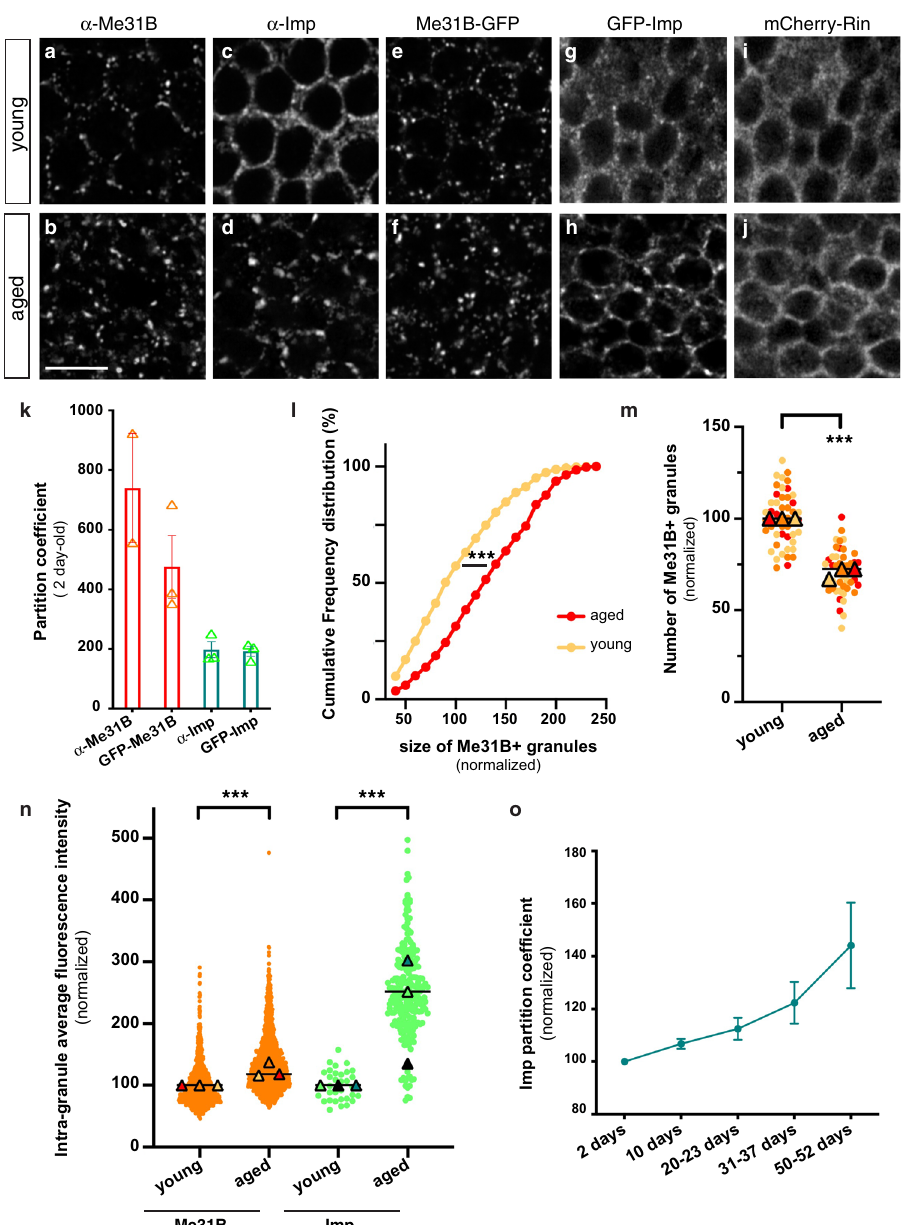
Fig. 1 Me31B and Imp condensate into larger cytoplasmic granules in aged brains. a – j Cell bodies of MB γ neurons imaged from 1 – 2 day- ( a , c , e , g , i ; young), or 37 – 38 day- ( b , d , f , h , j ; aged) old brains. Brains were stained with anti-Me31B ( a , b ) or anti-Imp ( c , d ) antibodies. Me31B-GFP ( e , f ), GFP-Imp ( g , h ) and mCherry-Rin ( i , j ) were expressed from their endogenous locus. Note that dark nuclei occupy most of the soma, and that the cytoplasmic signal is restricted to the cell periphery. Scale bar: 5 μ m. k Mean granular:cytoplasmic intensity ratio (partition coef fi cient) in brains of 1 – 2 day-old fl ies. Each data point represents the mean value of one replicate. At least 10 fi elds were analyzed per replicate. Two to three independent experiments were quanti fi ed per condition. l Normalized sizes of Me31B-containing granules in neurons of 1 – 2 day- (young) and 37 – 38 day- (aged) old brains. Frequency distributions are plotted for one replicate, but three were performed (see Supplementary Fig. 1a). *** P <0.001 (unpaired t-test on individual data points). m Normalized numbers of Me31B-containing granules (per surface area) in MB γ neurons of 1 – 2 day- (young) and 37 – 38 day- (aged) old brains. Three replicates were performed and the mean value of each is indicated as a triangle. Data points were color-coded based on the replicate they belong to. In l , m , individual data points were collected from brains immunostained with anti-Me31B antibodies and normalized to the young condition. *** P <0.001 (unpaired, two-sided t -test on individual data points). n Intra-granule concentration of Me31B (orange) and Imp (green) in 1 – 2 day- (young) and 37 – 38 day- (aged) old brains. Concentrations were estimated by measuring the mean intensity of Me31B-GFP and GFP-Imp signals within masks of corresponding granules. Three replicates were performed and the mean value of each is indicated as a triangle. The distribution of individual granule mean intensities is shown for one replicate only. *** P <0.001 (unpaired, two sided t-test on individual data points). o Imp mean partition coef fi cients upon aging. Each data point represents the average of mean values obtained from three independent replicates. Error bars correspond to s.e.m. Source data are provided as a Source Data fi